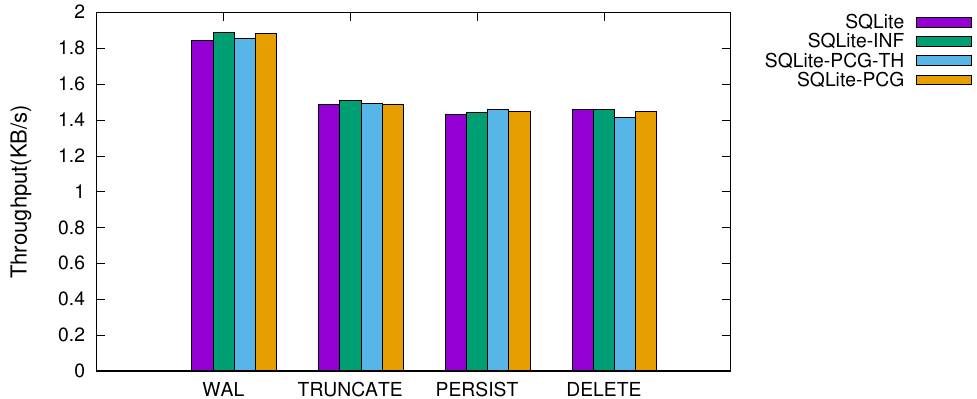
Figure 7. Throughput of 10 KB transaction in four different versions of SQLite.